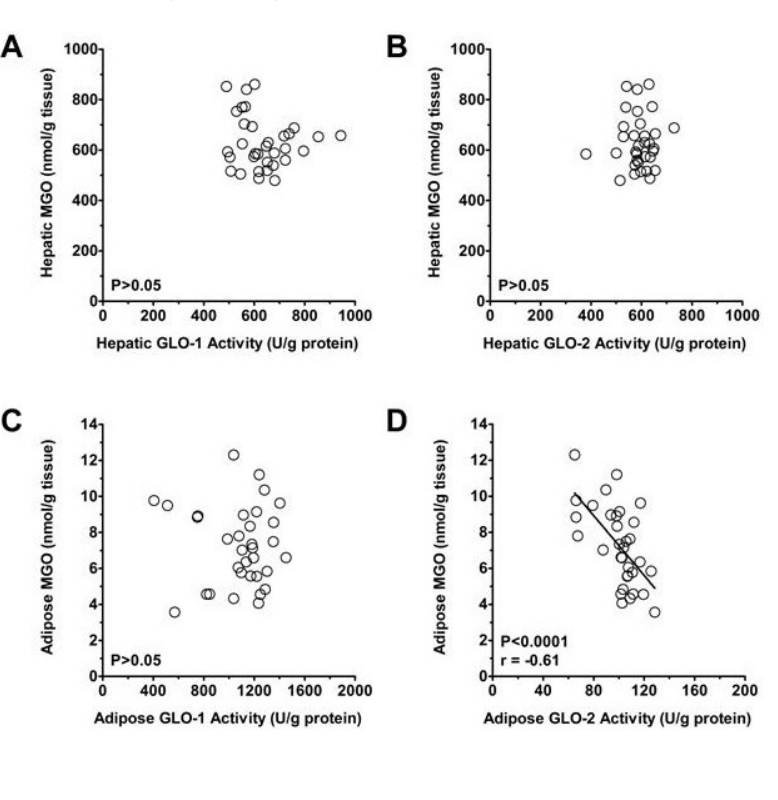
Figure 5. ( a ) Linear regression of MGO on hepatic GLO-1 activity. ( b ) Linear regression of hepatic MGO on hepatic GLO-2 activity. ( c ) Linear regression of adipose MGO on adipose GLO-1 activity. ( d ) Linear regression of adipose MGO on adipose GLO-2 activity. The relation between adipose GLO-2 and adipose MGO was significant ( P < 0.0001), but the other relations were not ( P >